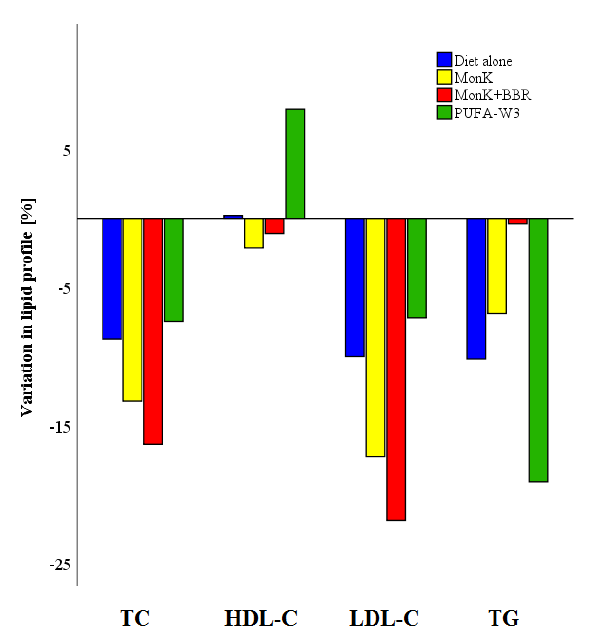
ff erent NUTs groups.